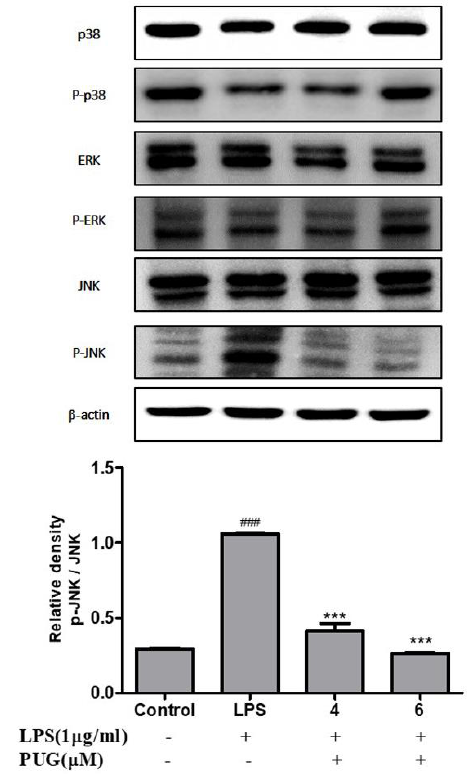
Figure 8. Effect of PUG on activating MAPKs in LPS-stimulated RAW264.7 cells: RAW264.7 cells were pretreated without or with LPS (1 µ g/mL) for 1 h at 37 ◦ C. Then the cells were treated with PUG (4, and 6 µ M) for 24 h at 37 ◦ C. After treatment, the protein was harvested from the cells and a Western blot was performed. The values were calculated by densitometry and the relative density was calculated with the total form of the protein. Three independent values were used for the calculation. The statistical significance was ### p < 0.001 vs. untreated group; and *** p < 0.001 vs. LPS-alone treated group.